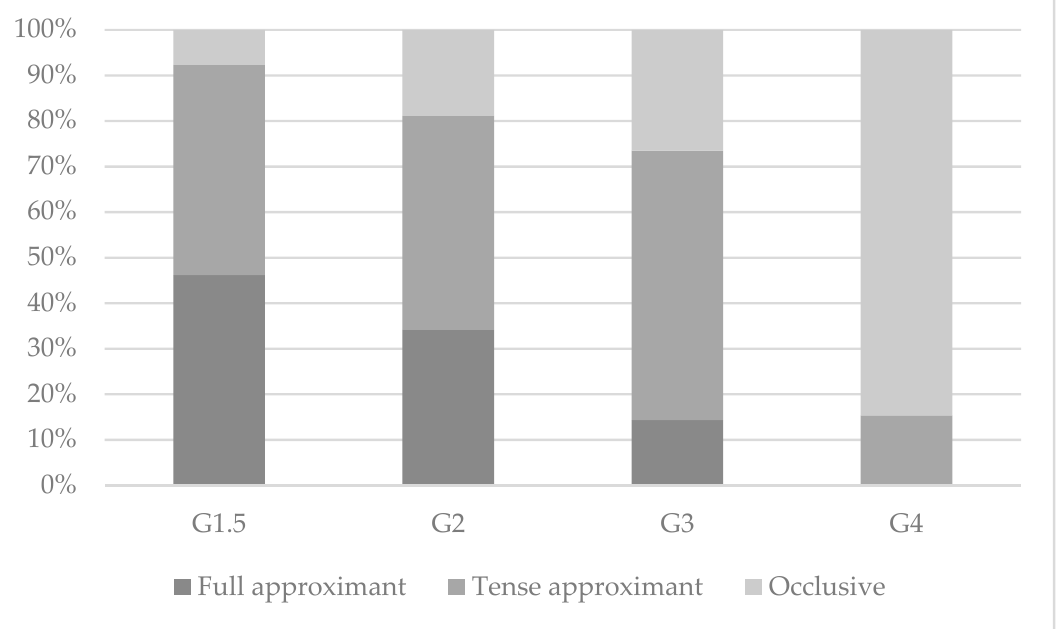
Figure 6. Rates of /b/ production types by generation.